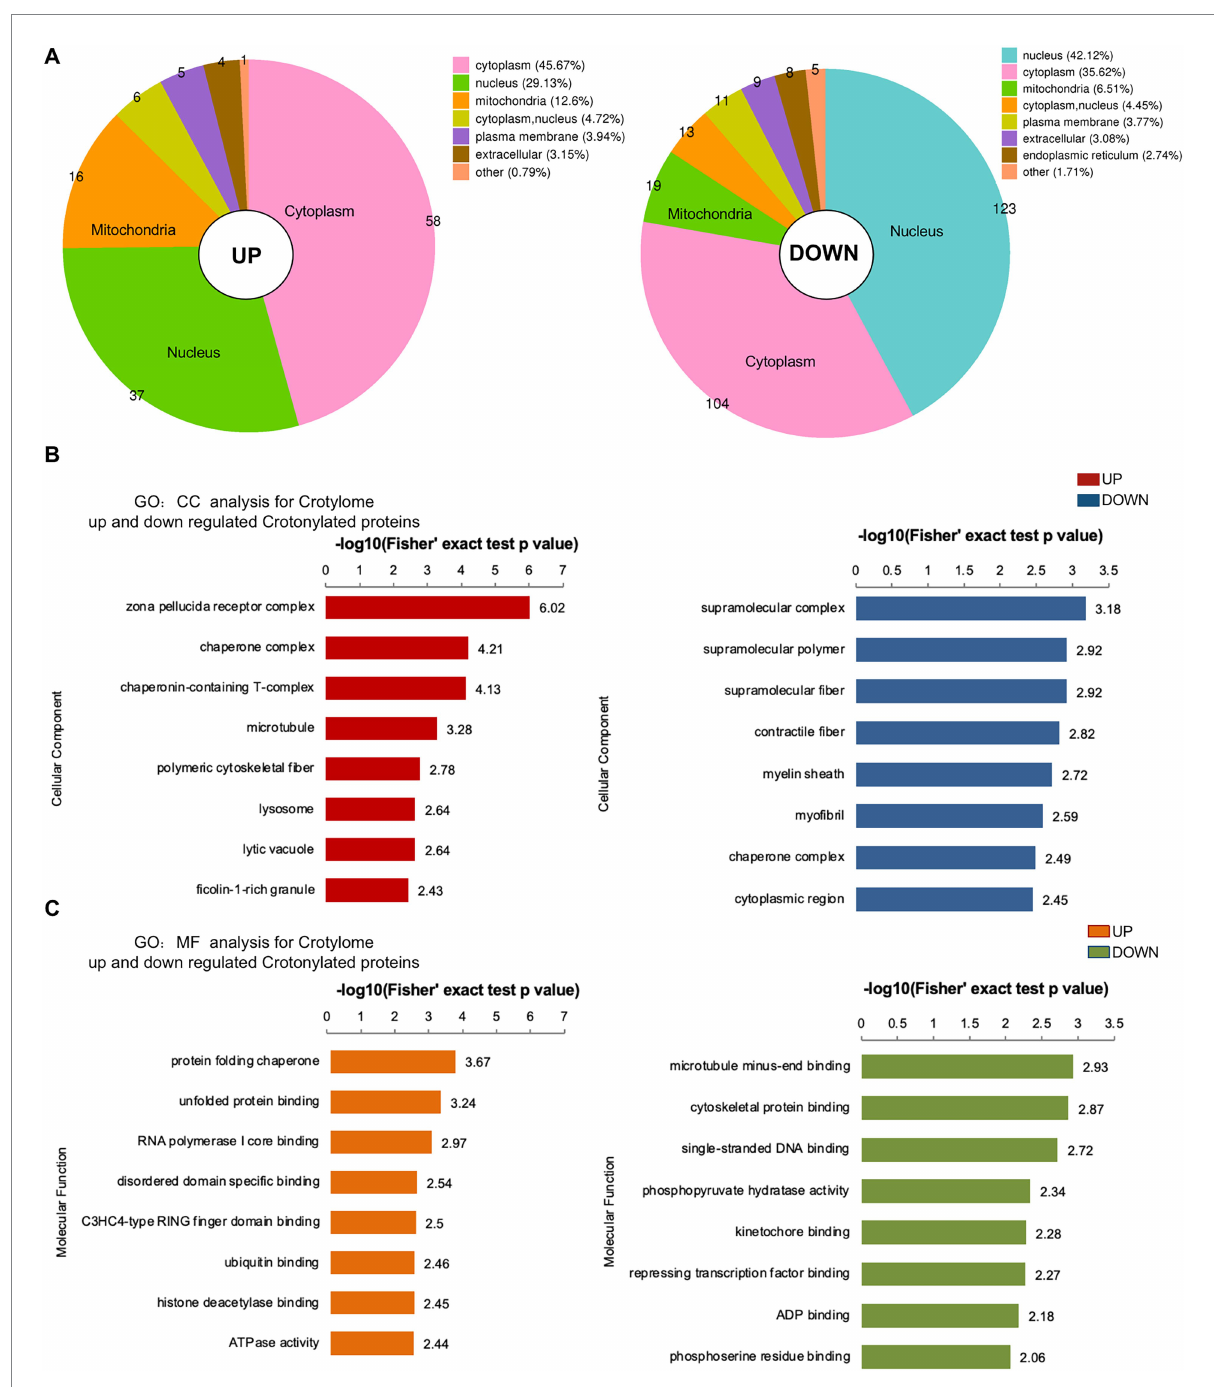
FIGURE 6 Subcellular location, MF and CC analysis of significantly up- and down-regulated crotylated proteins in folate-free mESCs. (A) Subcellular location analysis for significantly up- and down-regulated acetylated proteins, respectively. (B,C) Molecular function and cell component annotation for significantly up- and down-regulated crotylated